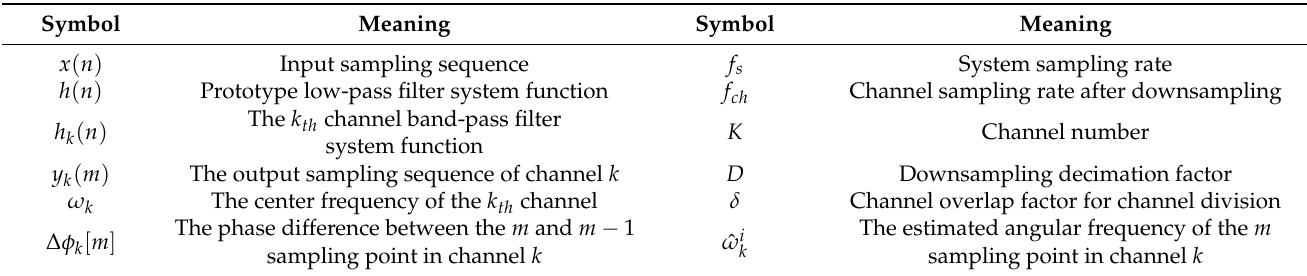
Table 1. The comparison table of symbols and their